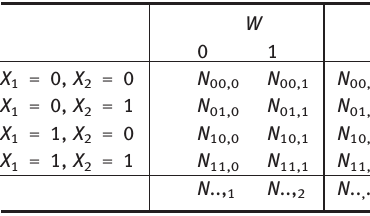
Table 2: Multiple categorical covariates : For the case of two categorical covariates, the combinations of the two categorical covariates can be treated as the levels of a single categorical